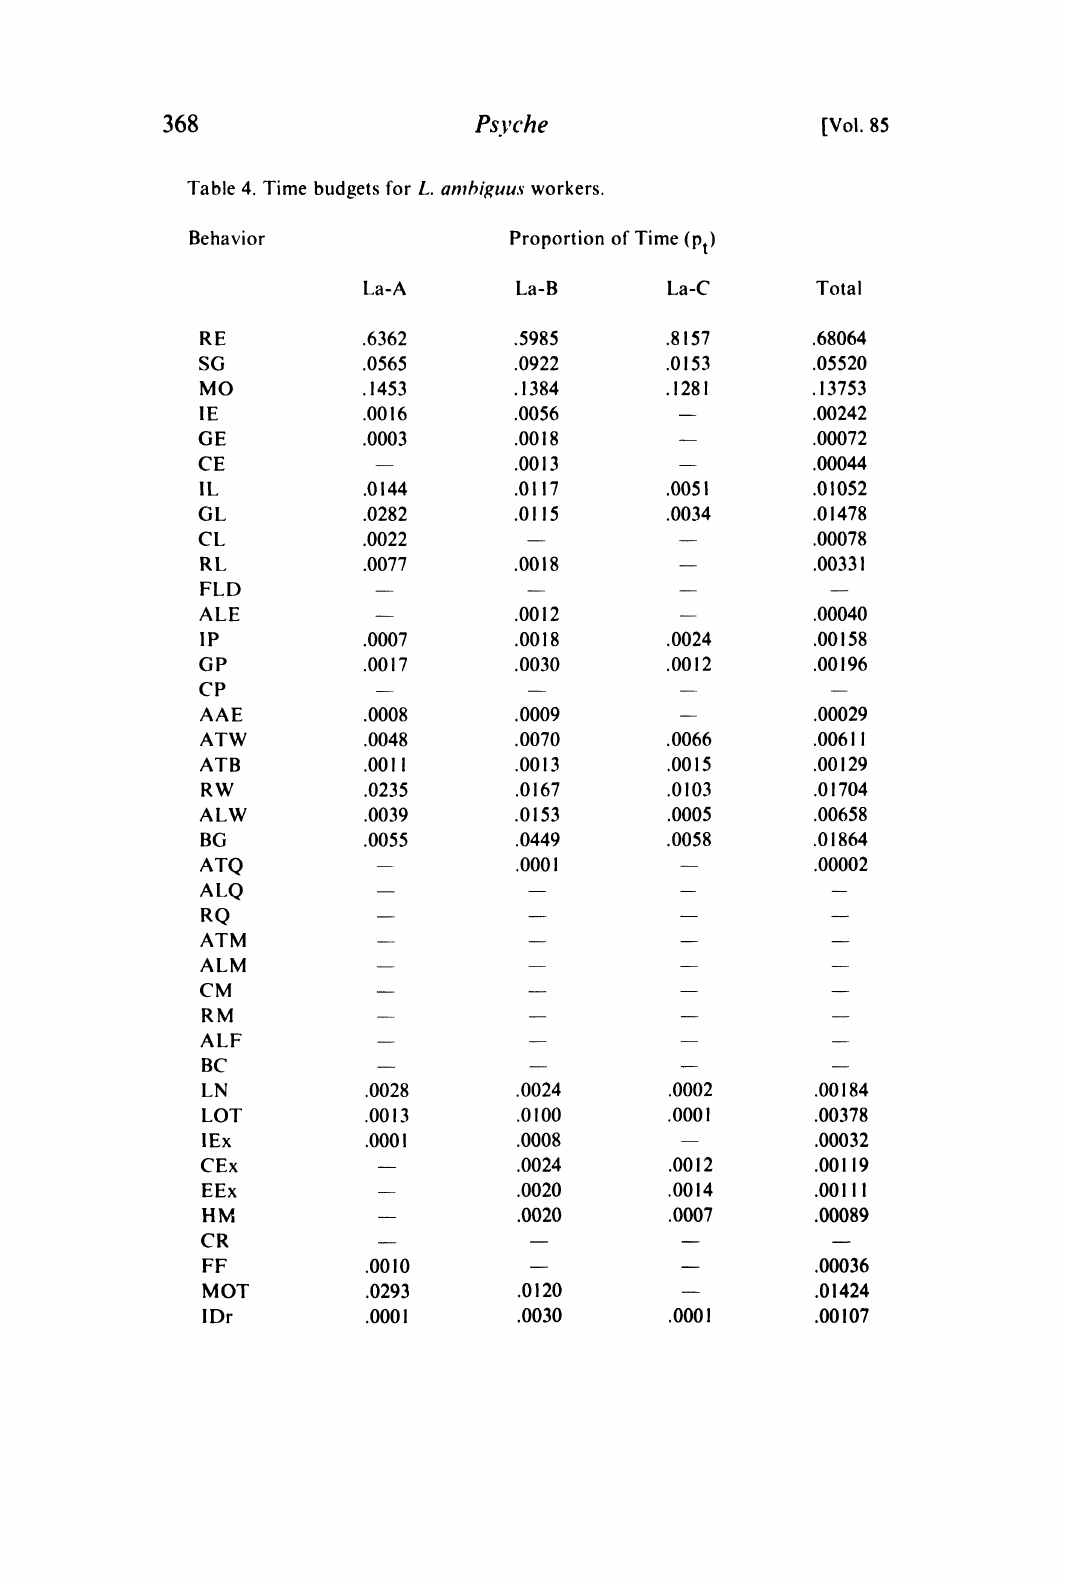
Table 4. Time budgets for L. ambiguus